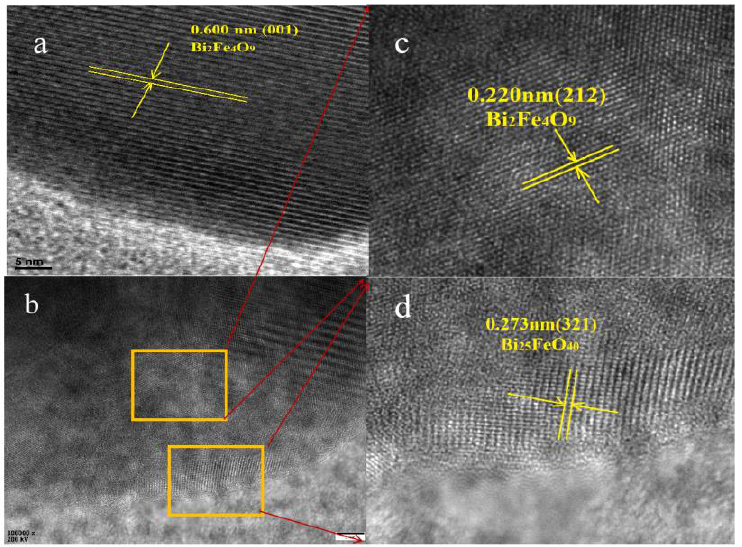
Figure 2. HRTEM image of ( a ) untreated BFO, ( b ) SPS650, ( c , d ) corresponding magnified image of ( d